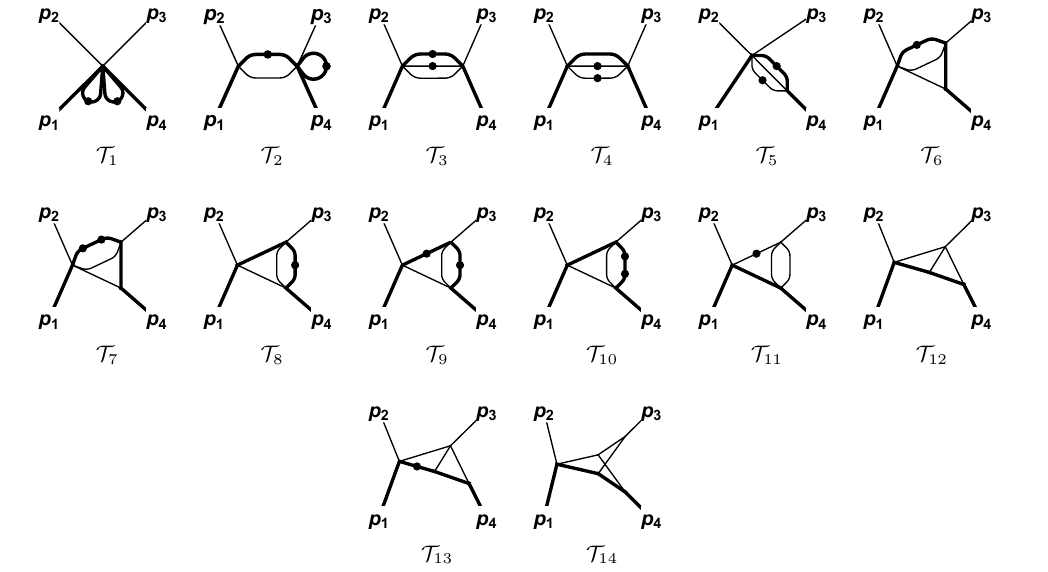
Figure 7. Two-loop MIs T